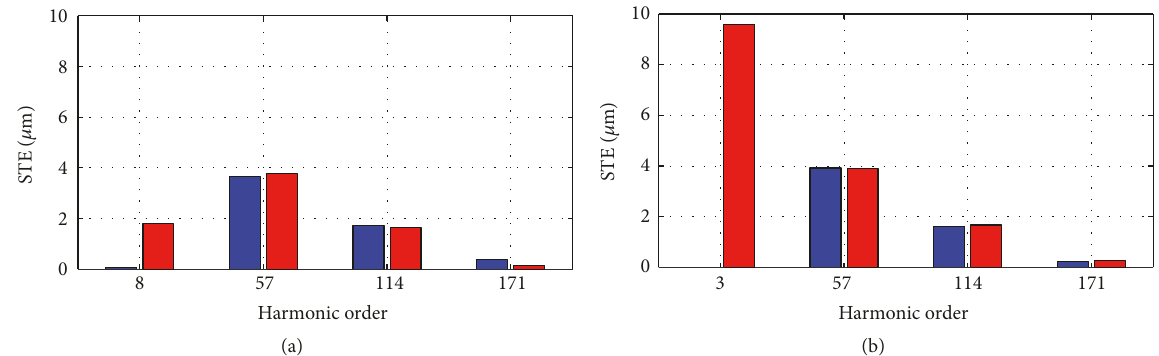
Figure 5: Amplitude of different harmonic components obtained from FFT of the STE curves computed for gear pairs (a and b) (a) and for gear pairs (c and d) (b). The rotational speed is kept constant in each simulation. Blue histograms refer to the axisymmetric gears.